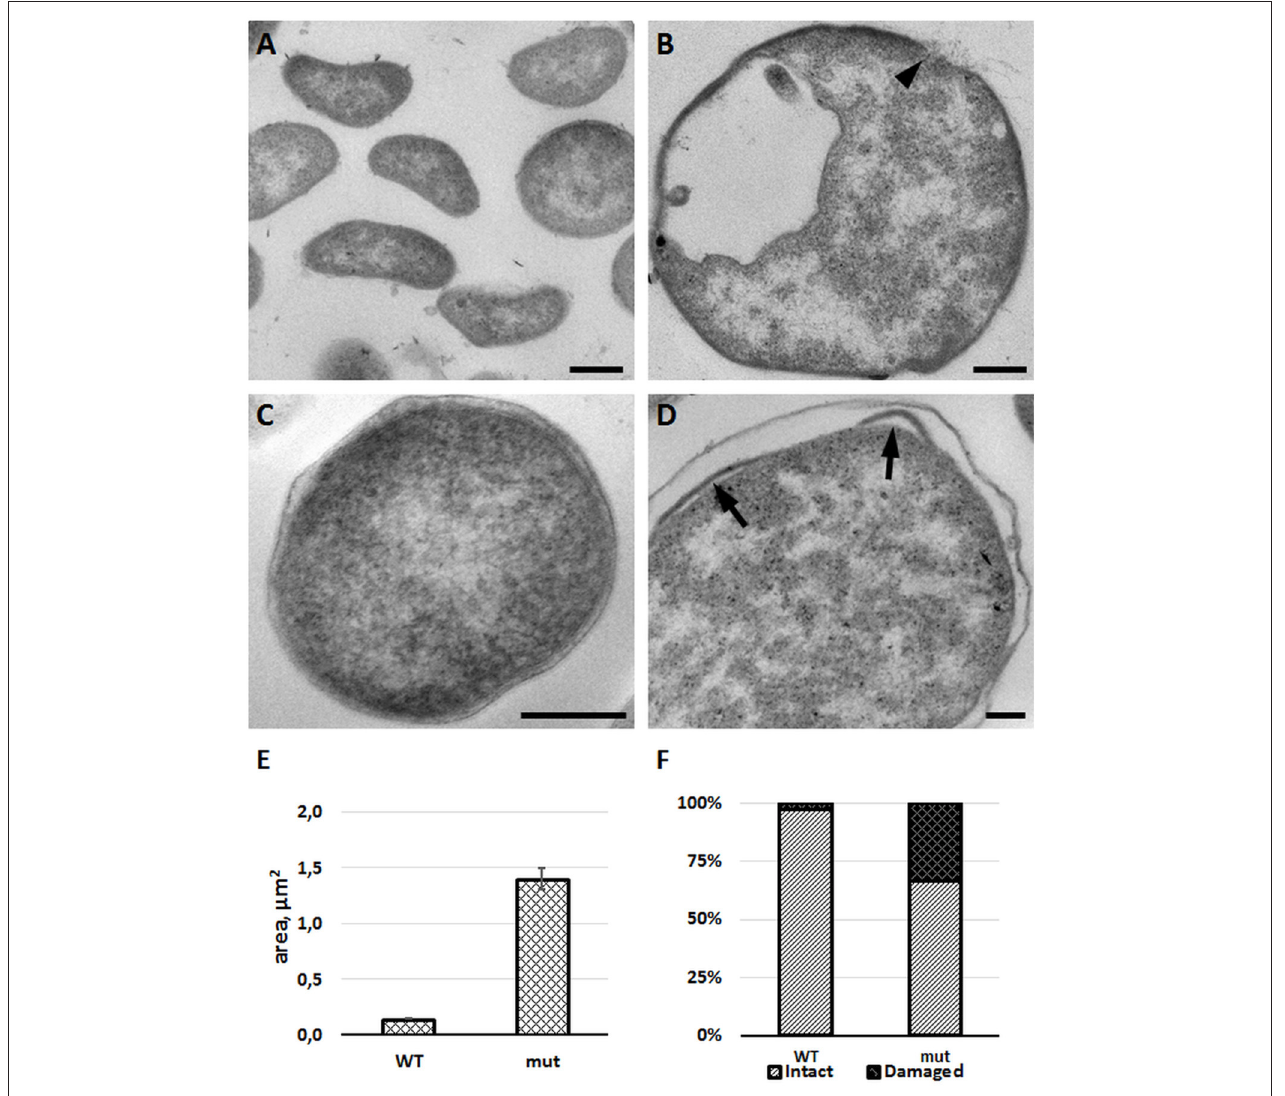
FIGURE 7 | FSC200/ in dacD mutant bacteria differ in size when compared to the wild-type and exhibit membrane defects . F. tularensis FSC200 wild-type strain (A,C) and FSC200/ in dacD mutant strain (B,D) were cultivated in CHM and then processed for transmission electron microscopy. Typical electron micrographs of ultrathin sections of bacteria in (A,B) at the same magnification illustrate size difference between wild-type and mutant strains. Wild-type cells possess intact membrane (C) , while mutant cells exhibit discontinuous membrane ( B , arrowhead) or membrane bulging ( D , arrows). (E) Graph showing mean cell profiles area of wild-type and mutant bacteria on ultrathin sections; (F) Quantification of incidence of cell profiles with membrane defects on ultrathin sections. Bars: (A,B) 200nm; (C,D)